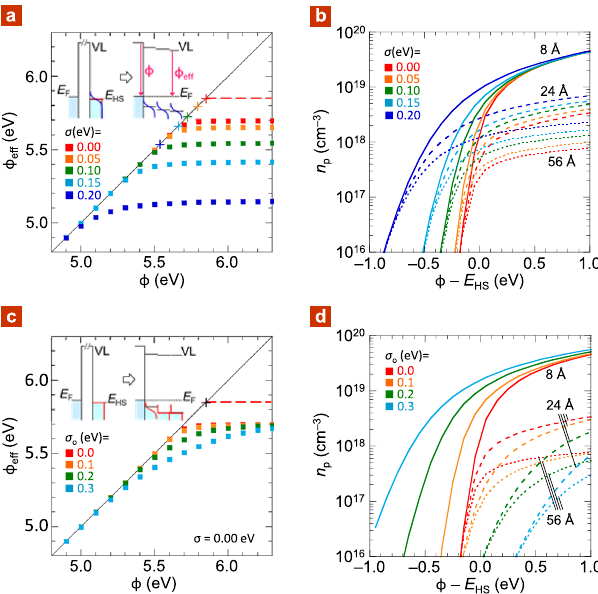
Fig. 3 Computational study of DOS effects in Heaviside model. a Fermi- level pinning plot for semiconductor with Heaviside DOS (5.85eV; 5.5× 10 20 eV – 1 cm – 3 ) convoluted with variable Gaussian width σ : Effective work function against vacuum work function of electrode. Red cross marks Heaviside energy E HS . Other crosses mark valence-band-edge energy E V set up by corresponding σ . b Plot of hole density against ϕ offset by E HS , for the cases in ( a ), at z = 8 Å (i.e., middle of ML0), 24Å (ML1), and 56Å (ML3). c Fermi-level pinning plot for Heaviside DOS where only ML0 is convoluted with variable Gaussian width σ o . d Plot of hole density against ϕ offset by E ϕ z = 15 nm. Other parameters: HS , for the cases in ( c ). eff is evaluated at semiconductor dielectric constant, perpendicular to contact, ε r = 2.1; charge- screening distance into electrode, d o = 5Å; ML thickness, d ML = 16Å; temperature, T = 298K; numerical convergence quality, 1